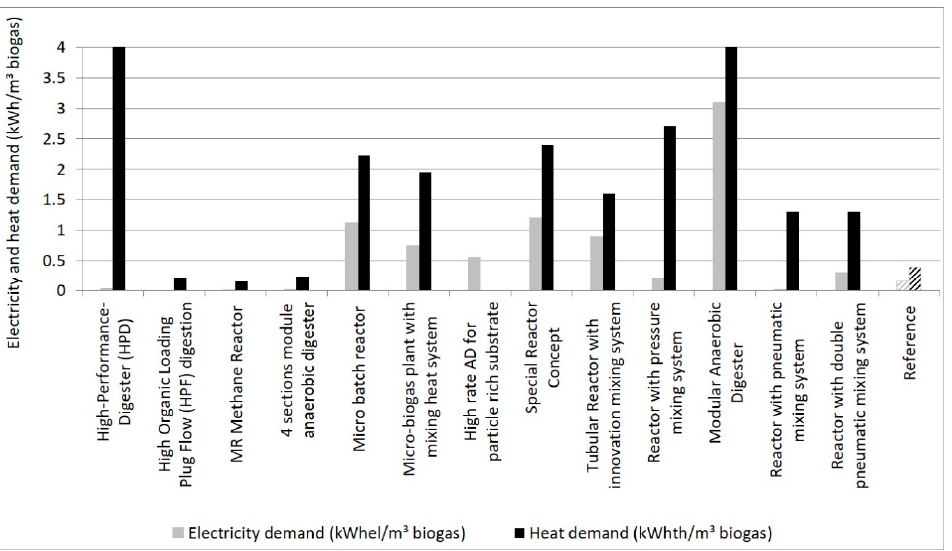
Figure 3. Electricity and heat demand for digestion technologies.